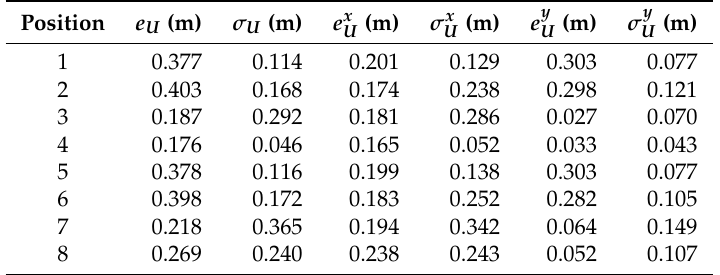
Table 8. Measured accuracy of the POST U algorithm in Scenario 3.